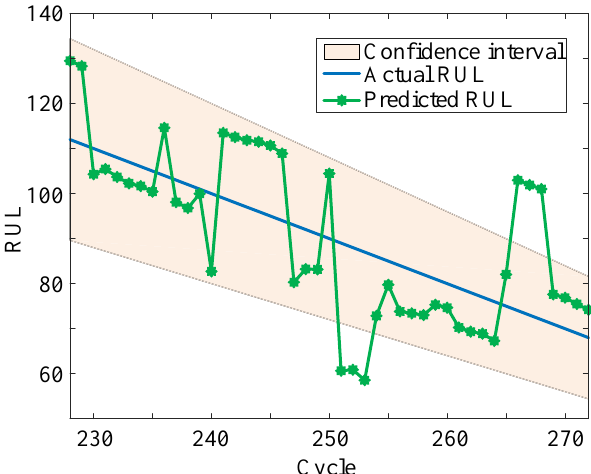
Figure 9. The predicted results under different lengths of the sample to be predicted. RUL, remaining useful life.